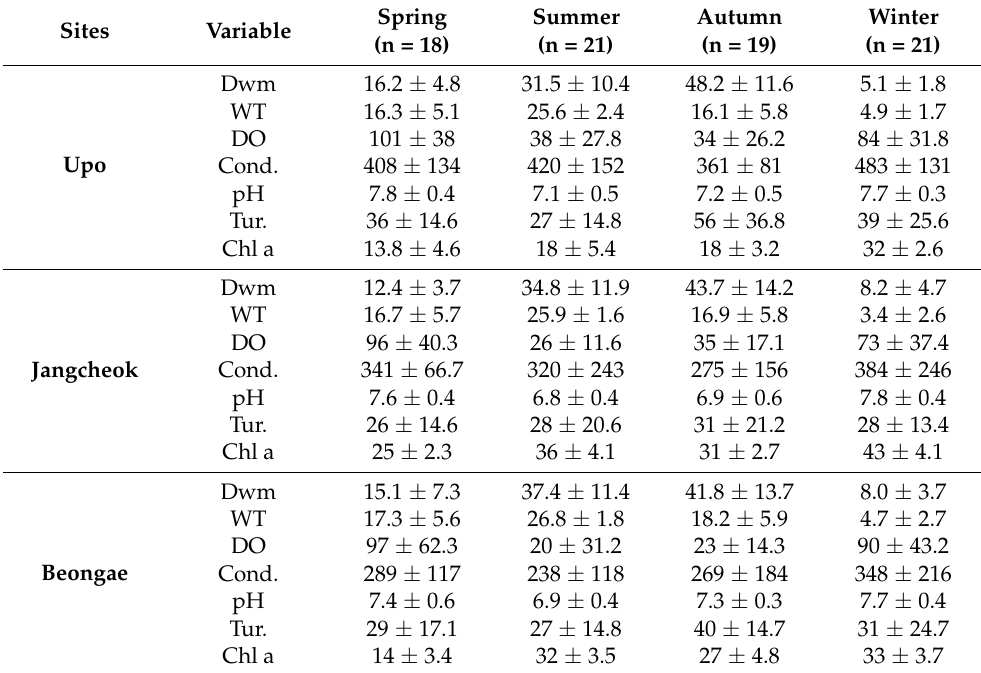
Table 1. Seasonal variations in environmental variables measured at three wetlands (Upo, Jangcheok, and Beongae wetlands). Dwm, dry weight (g) of macrophyte; WT, water temperature ( ◦ C); DO, % saturation of dissolved oxygen; Cond., conductivity ( µ S cm − 1 ); Tur., Turbidity (NTU); Chl a,